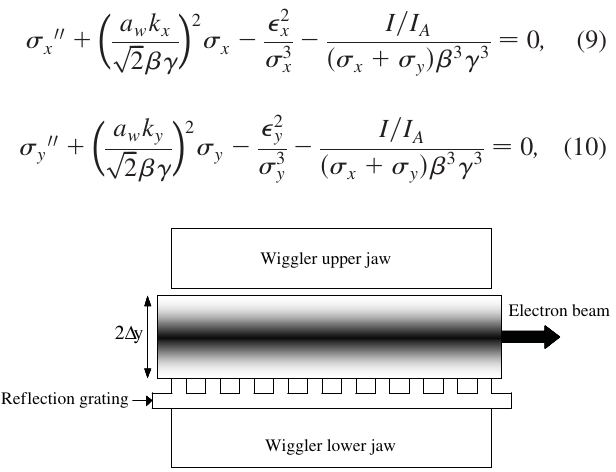
FIG. 2. Schematic of focusing in a Smith-Purcell BWO using